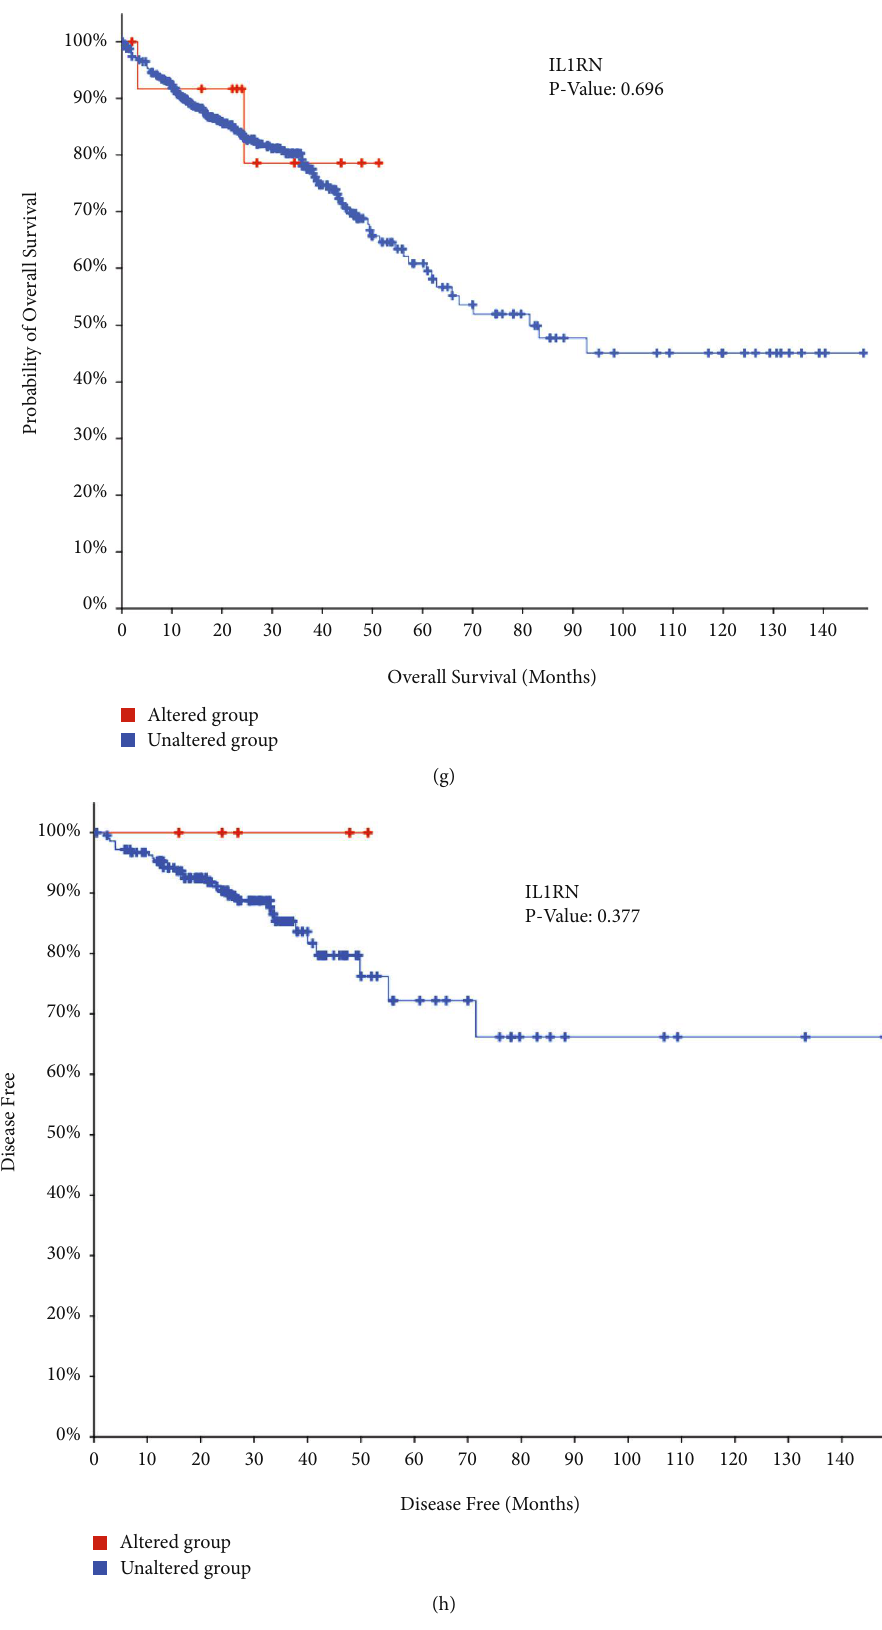
Figure 4: (a) – (d) and (g) Overall survival and (e), (f), and (h) disease-free survival analyses of hub genes were performed using cBioPortal online platform. P < 0 : 05 was considered statistically signi fi